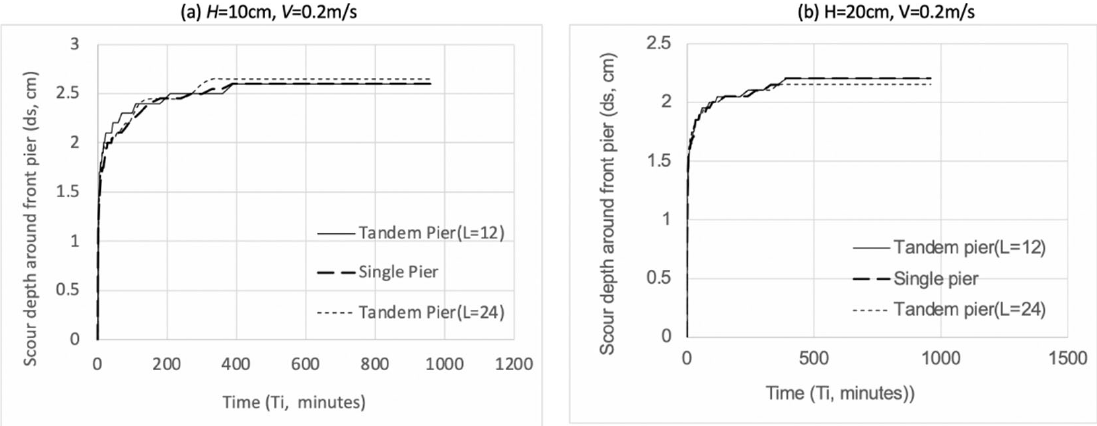
Figure 3. Variation in depth of scour hole with time around the front pier of the tandem double piers compared to that around a single pier condition. ( a ) H = 10 cm, V = 0.2 m/s; ( b ) H = 20 cm, V = 0.2 m/s).